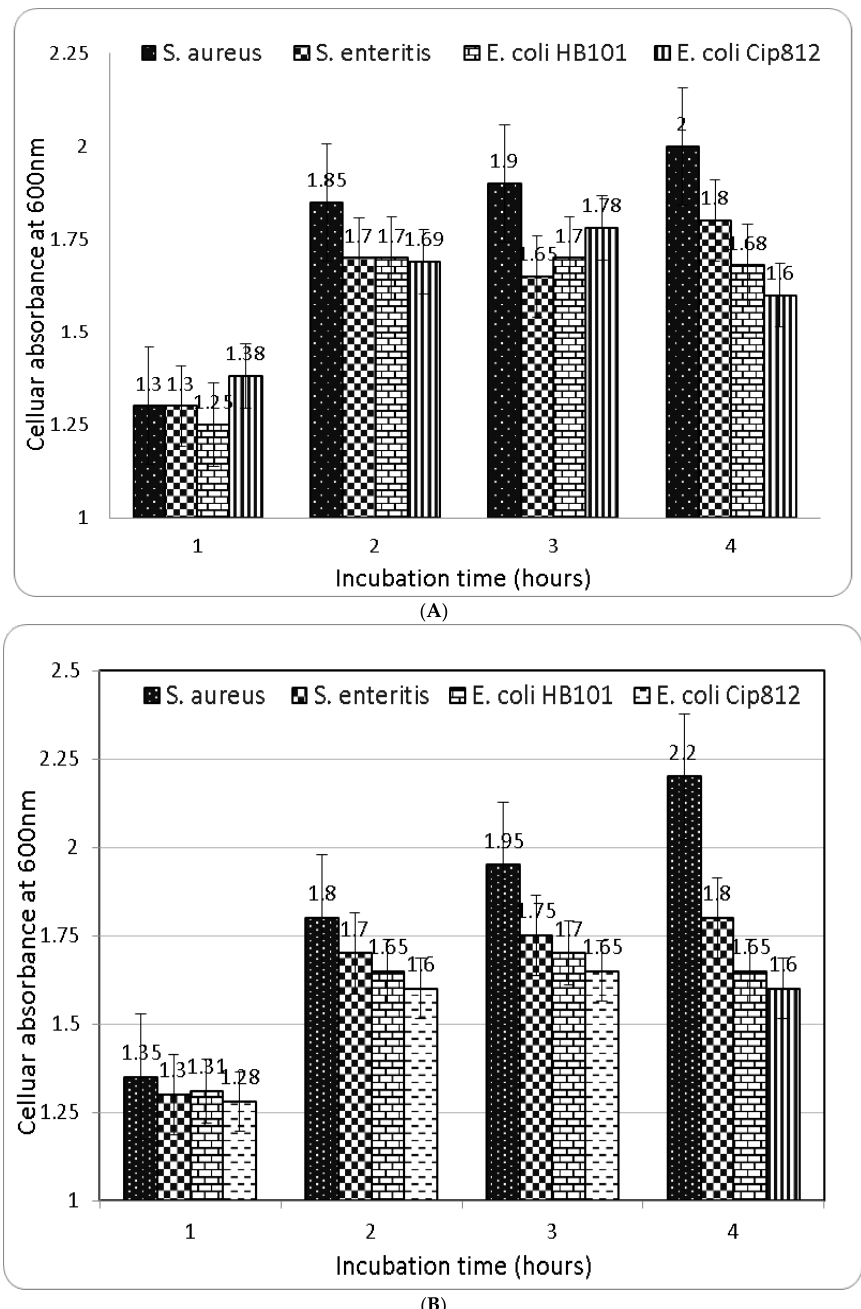
Figure 3. Antibacterial activity of Berberis vulgaris root ( A ) and leaf ( B ) against common food borne pathogenic bacteria.